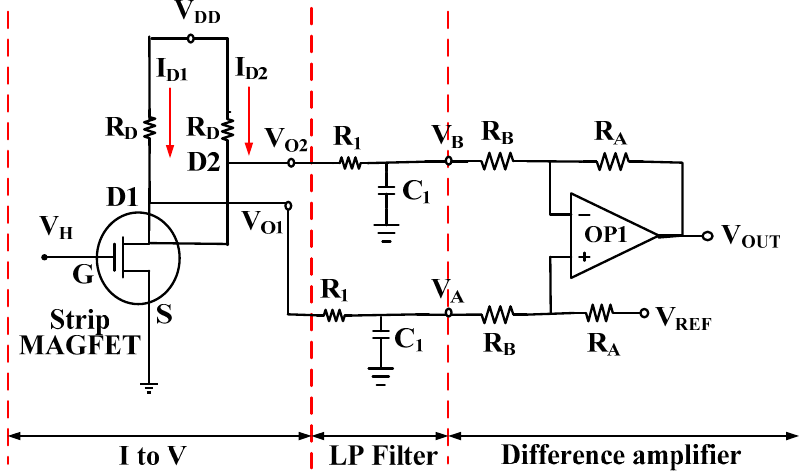
Figure 2. Readout circuit of the proposed distance detector comprising an I-to-V converter, low-pass filter (LPF), and difference amplifier (DA).